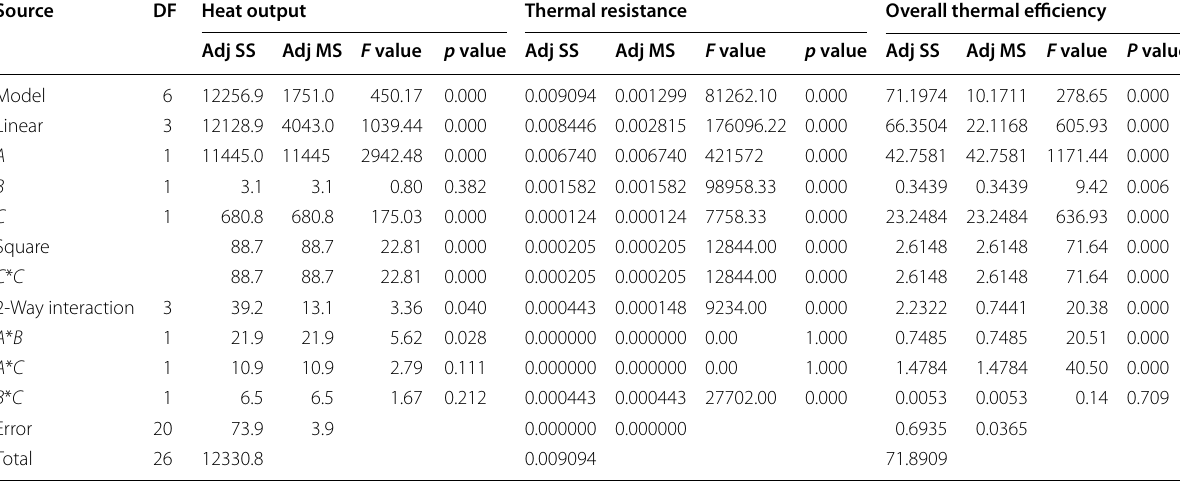
Table 3 ANOVA results of output characteristics of a flat absorber plate